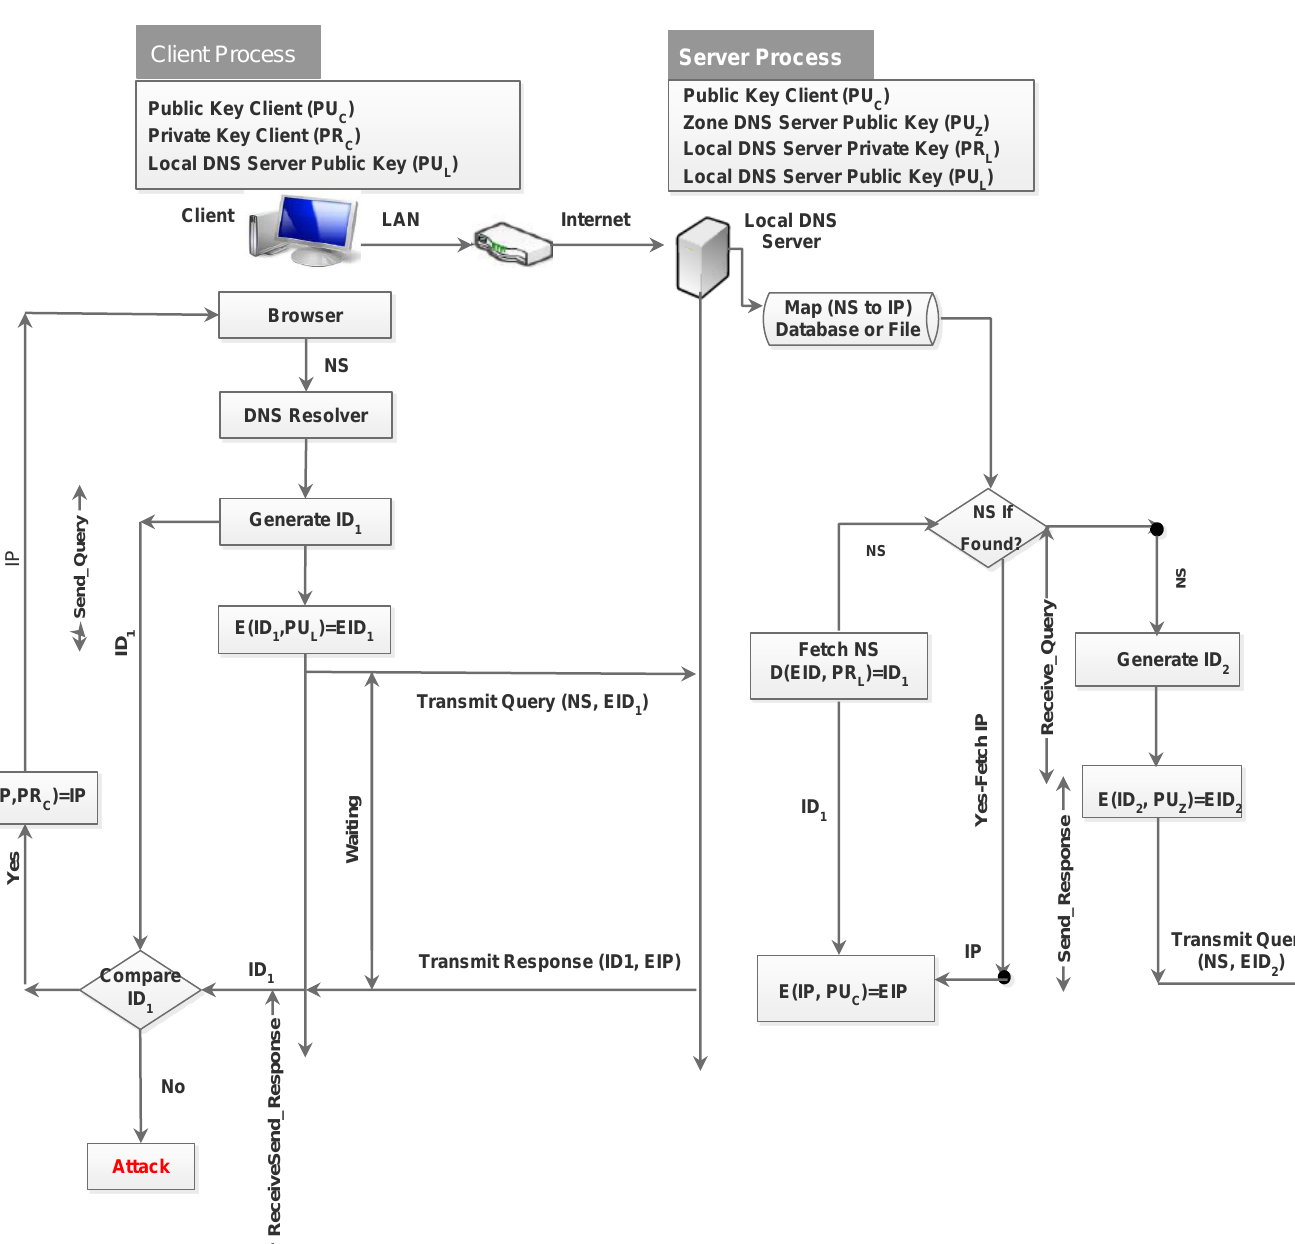
Figure 2. System Flow of Proposed System